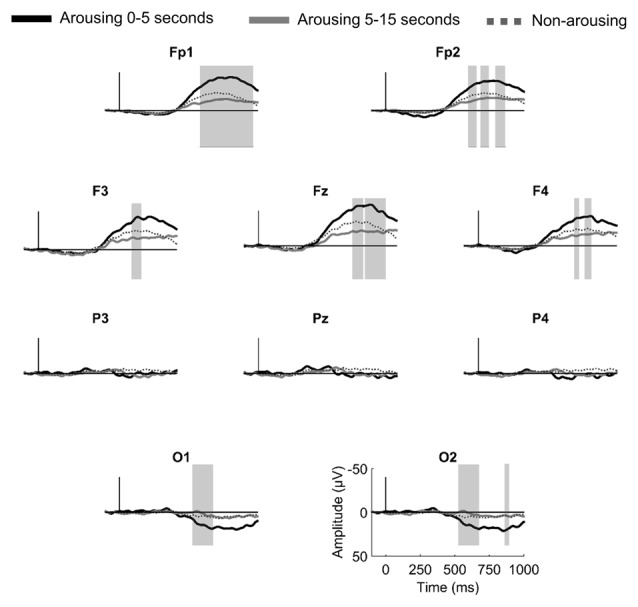
Brain responses to first names leading to a rapid arousing reaction (in the 5 s post stimulus, black thick line), to a delayed arousing reaction (between 5 s and 15 s post-stimulus, gray thick line) and to no arousing reactions (dotted line) in N2 sleep. Gray vertical bars highlight significant differences between rapid and delayed arousing reactions (sample-by-sample Kruskal-Wallis test, p < 0.05 for more than 15 ms).